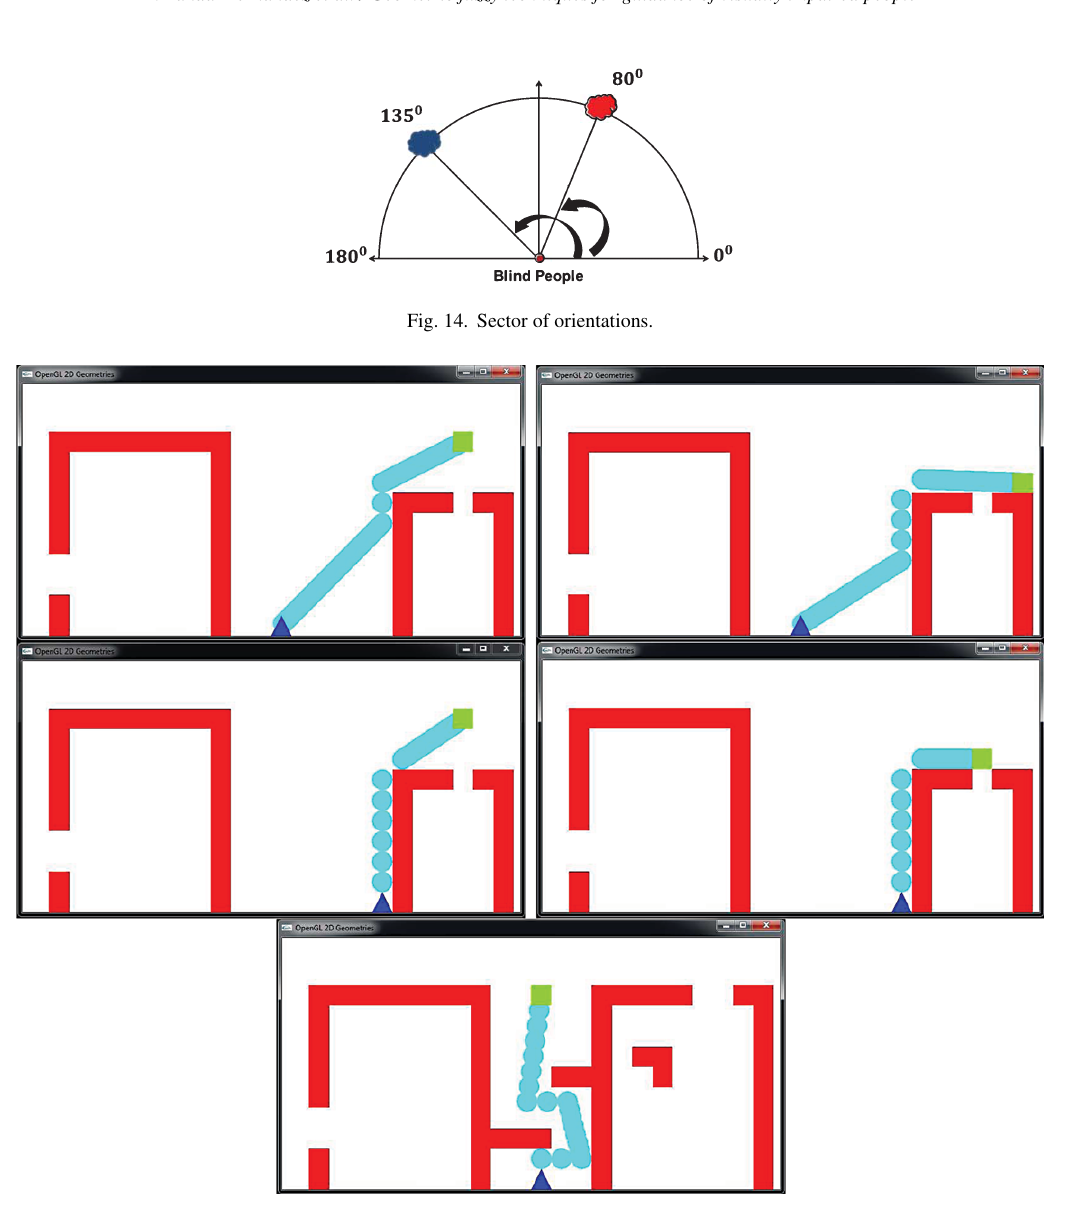
Fig. 15. Examples of path following by different navigation